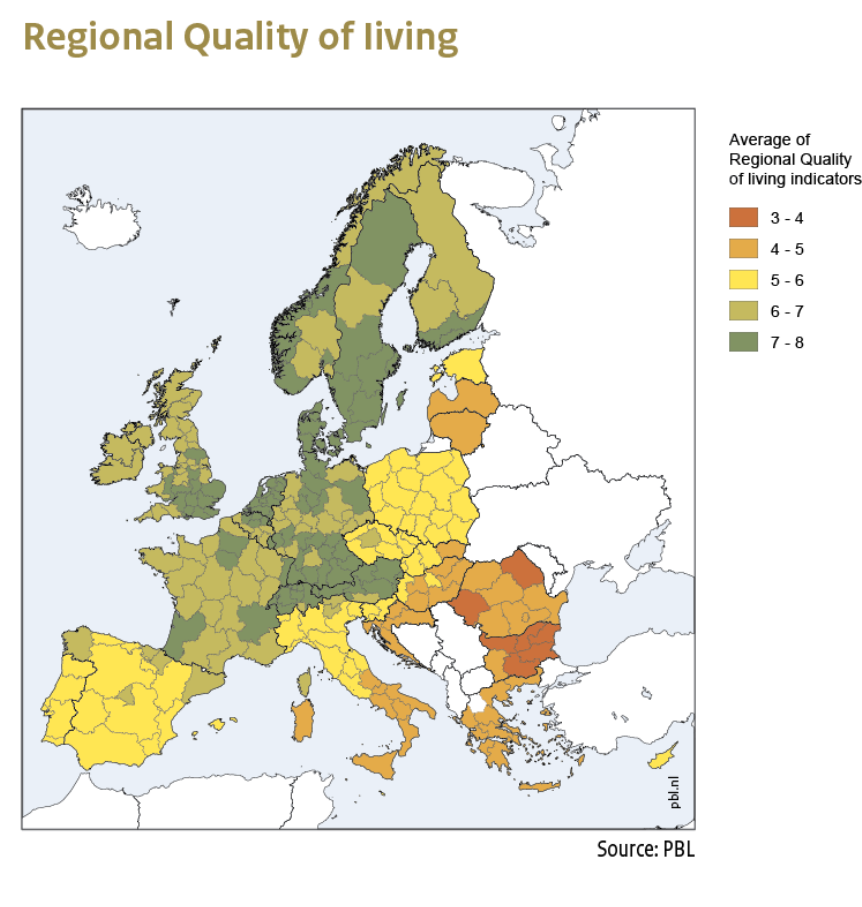
Figure 3: The Regional Quality of Living Index for European regions. Calculated as the average score of nine RQI indicators, each scaled 1 to 10